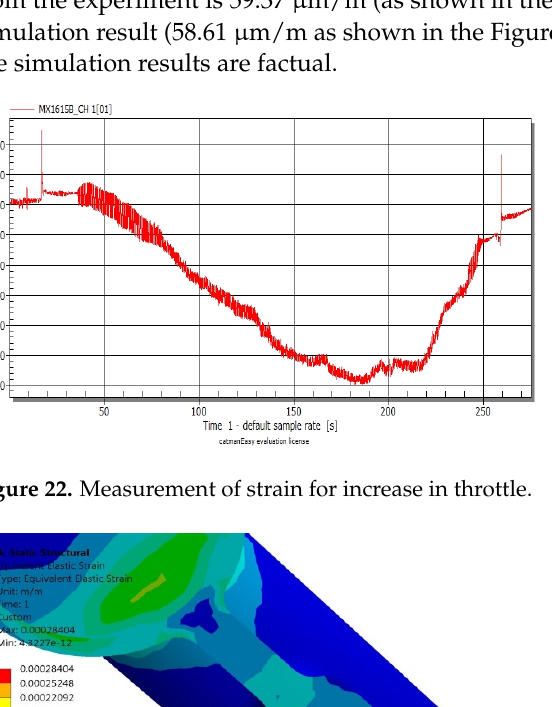
Figure 21. Strain induced during hovering, yaw left, yaw right, pitch up, pitch down, roll left and roll right.